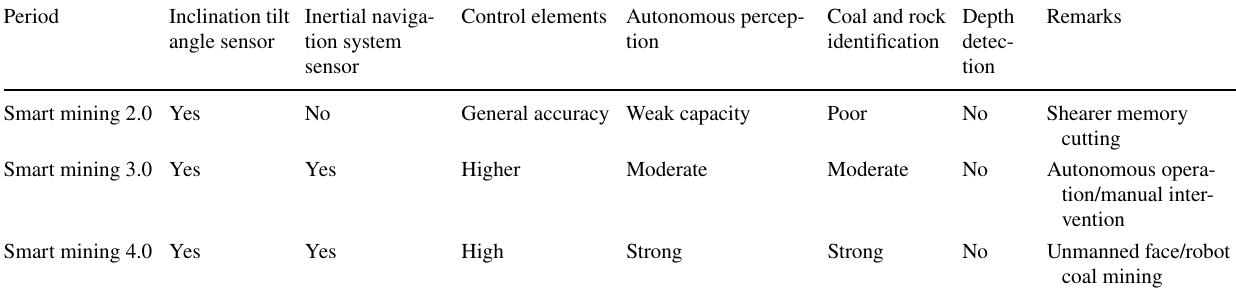
Table 1 Design of experimental